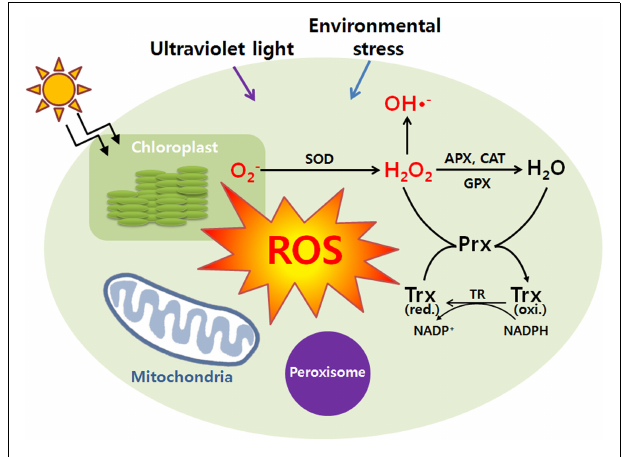
FIGURE 1 | Cellular responses against reactive oxygen species. During a variety of stress conditions (UV, environmental stress, etc), reactive oxygen species (ROS) can be generated. At the start of the reaction, a primary ROS which is superoxide anion (O 2 − ) can be formed by the one electron reduction of molecular oxygen.The superoxide anion (O 2 − ) is dismutated by superoxide dismutase (SOD) to hydrogen peroxide (H 2 O 2 ) which is detoxified by catalase (CAT), ascorbate peroxidase (APX), glutathione peroxidase (GPX), and peroxiredoxin (Prx). Once the superoxide anion (O 2 − ) is formed in the presence of H 2 O 2 , it becomes inevitable. Further reactions may lead to the formation of hydroxyl radicals (HO · ). Antioxidant proteins protected the damages of ROS leaking from peroxisomes. H 2 O 2 can easily permeate the peroxisomal membrane and play an important role in protection of cells from ROS damages. And various ROS transmitted to the mitochondrion play a role in the adaptive response of mitochondrial redox state, especially for the reduction state of respiratory pathways.The redox signals will be transmitted to the nucleus to regulate plant growth and developments.Trx represents